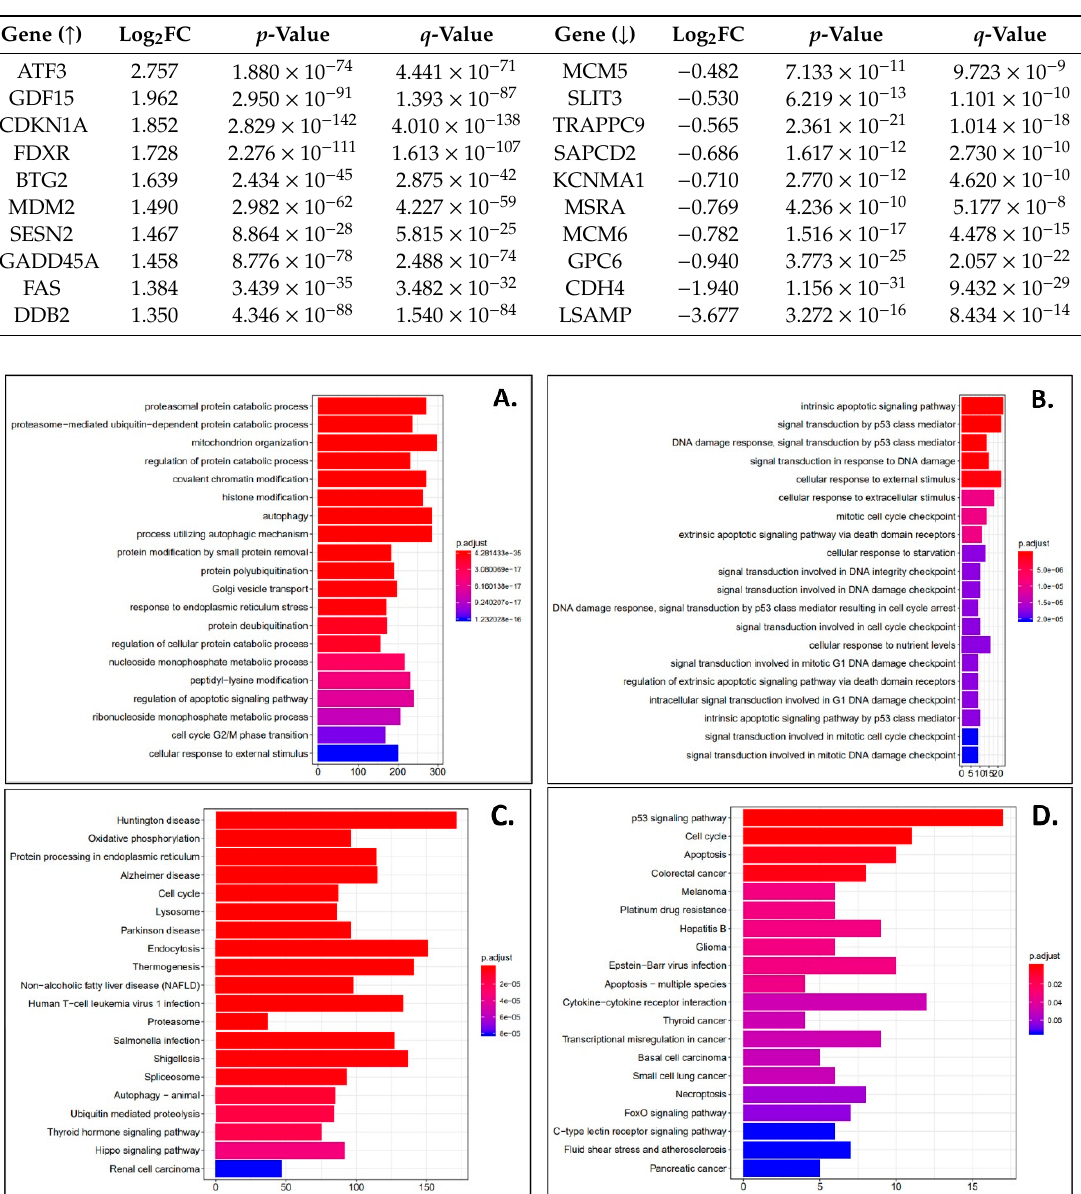
Table 2. Phenanthriplatin and cisplatin modulate gene regulation in A549 cells. Top 10 up- and downregulated DEGs for A549 cisplatin versus A549 control. DEG data analysis: ( p ≤ 0.05; q ≤ 0.05;